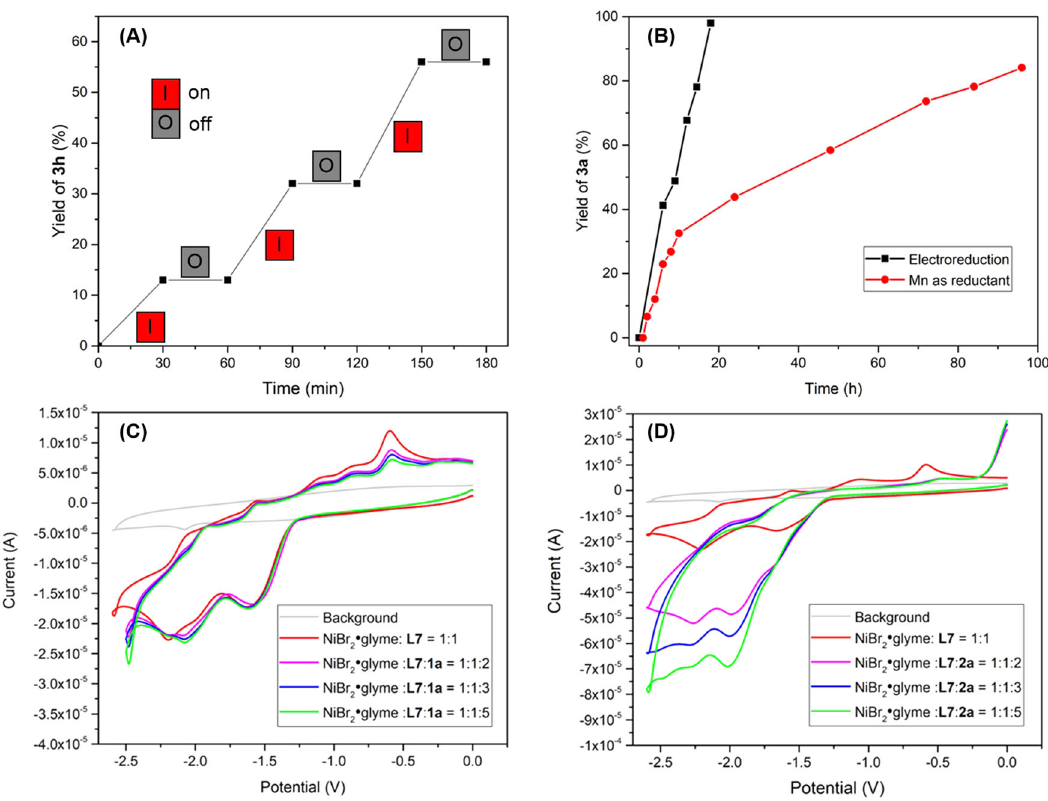
Fig.4|Mechanisticexperiments.A On/offexperiment. B Timecourseexperiment. C CVanalysisontheinteractionof 1a withthecatalyst. D CVanalysisontheinteraction of 2a with the